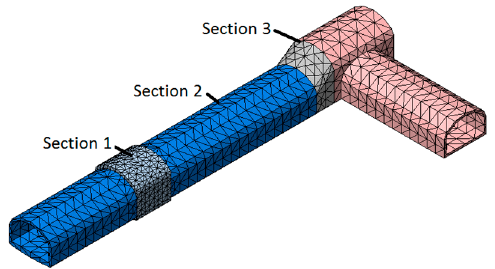
Figure 6. Tunnel lining grid and distribution of control sections.